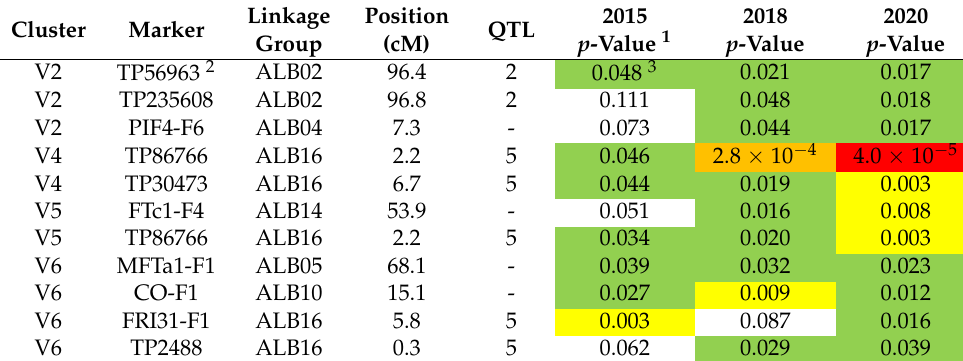
Table 3. Correlation between the phenotype (the number of days from sowing to flowering) and the genotype (marker segregation) in subpopulations of white lupin germplasm collection. Cluster